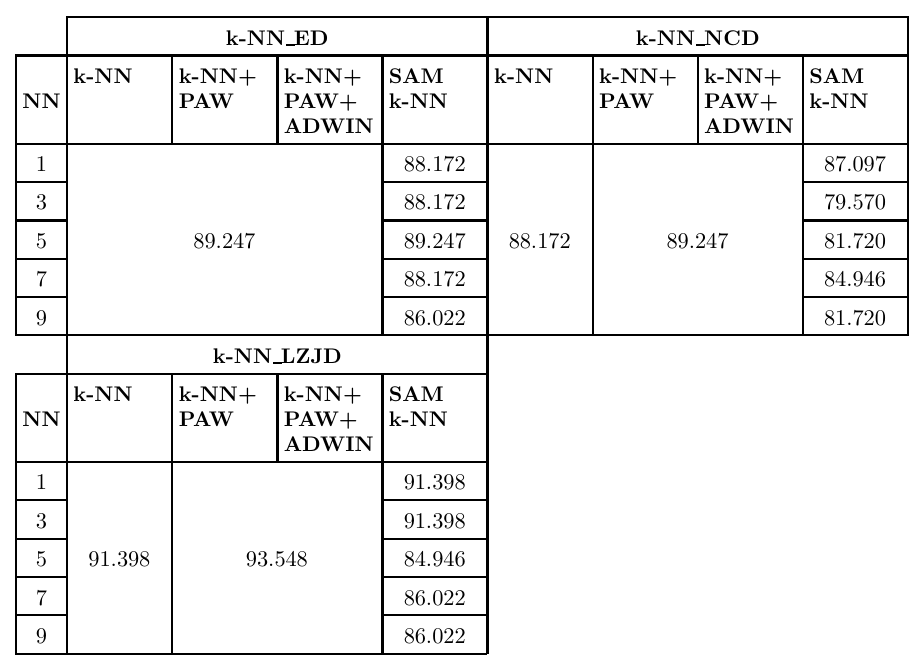
Table 3. K-nearest neighbour classification using Euclidean distance, Normalized Compression Distance, and Lempel-Ziv Jaccard Distance for the measurements taken from the third patient